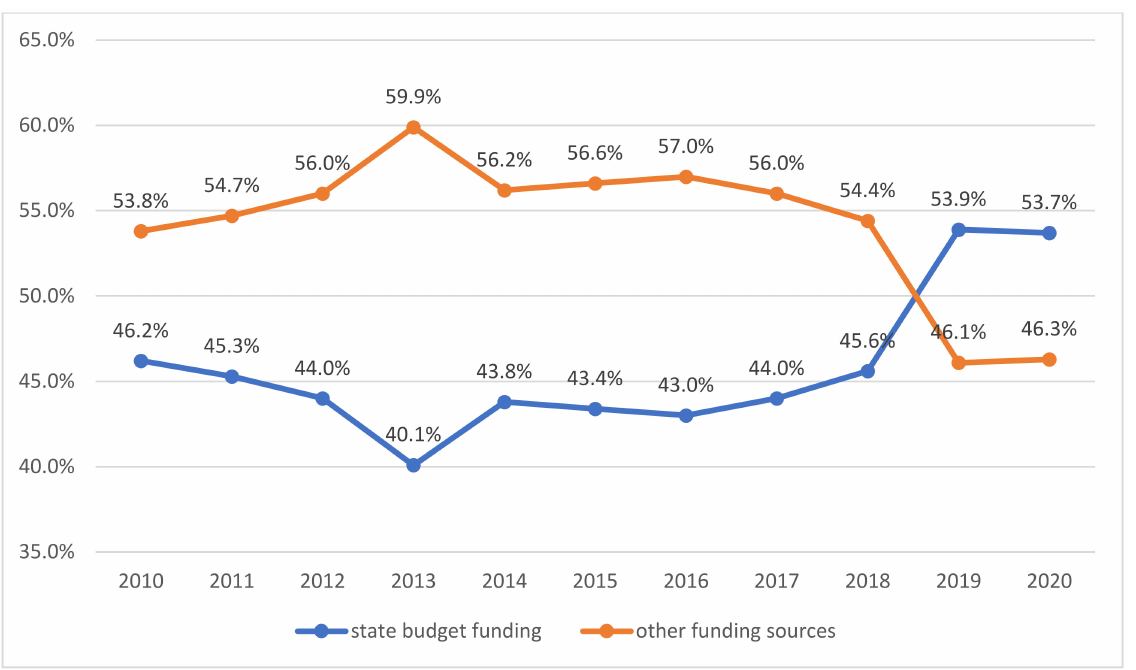
Figure 5. Sources of funding of the PRVT scheme, 2010–2020.